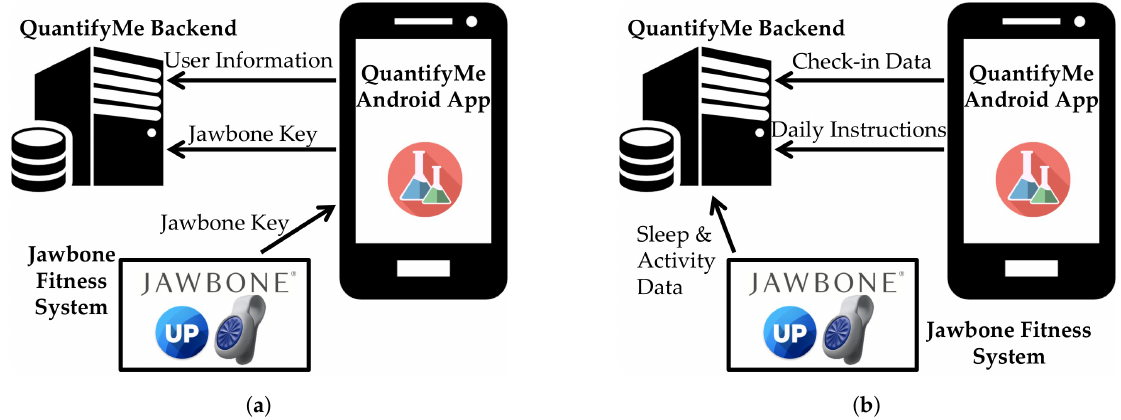
Figure 3. QuantifyMe platform schematics during: ( a ) installation; and ( b ) self-experiment. Note that the Jawbone Fitness System includes the Jawbone backend, the Jawbone Up App, and a Jawbone UpMove